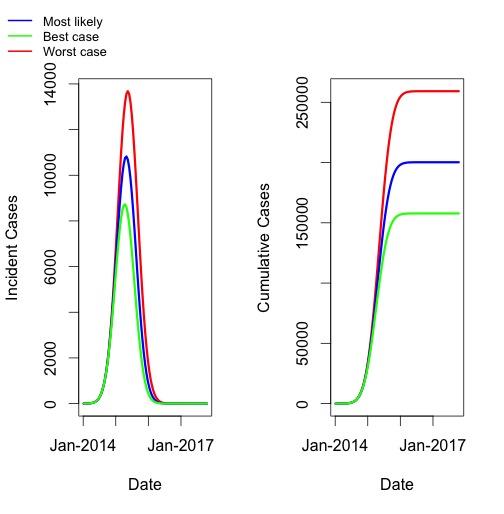
Long-term projections based on best-fit and upper and lower bound parameters. Blue curve represents most likely scenario, green curve represents best case, and red curve represents worst case. Incidence (per 15-day generation) is plotted on left; cumulative incidence on right.